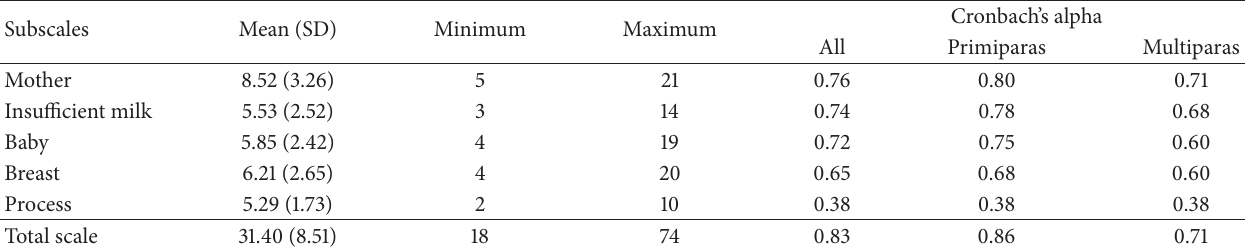
Table 4: Descriptive statistics and Cronbach’s alpha for the BES subscales as extracted by the